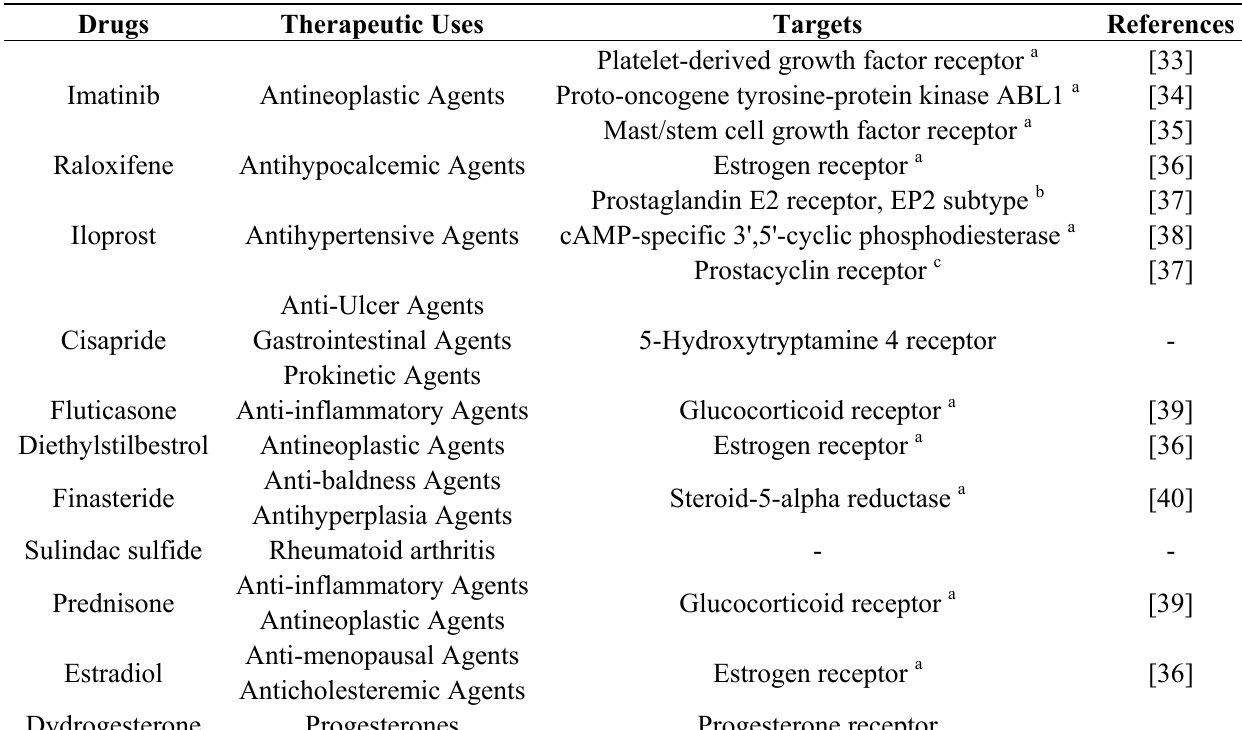
Table 1. Predicted similar drugs and associated targets of